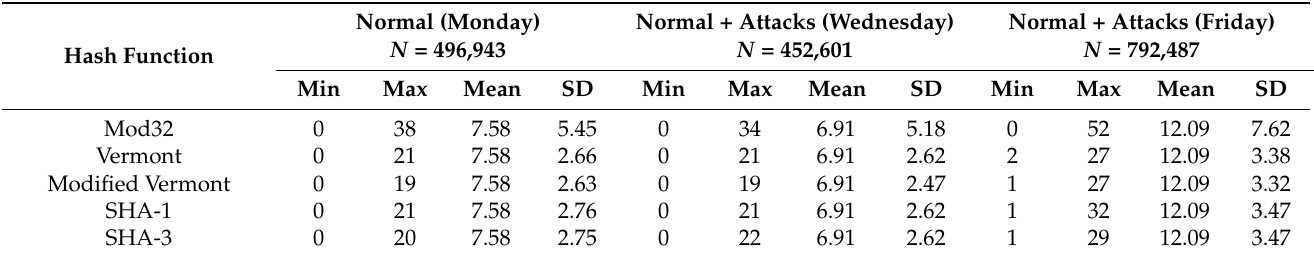
Table 6. Statistics of bucket occupation for various hash functions—2 16 buckets